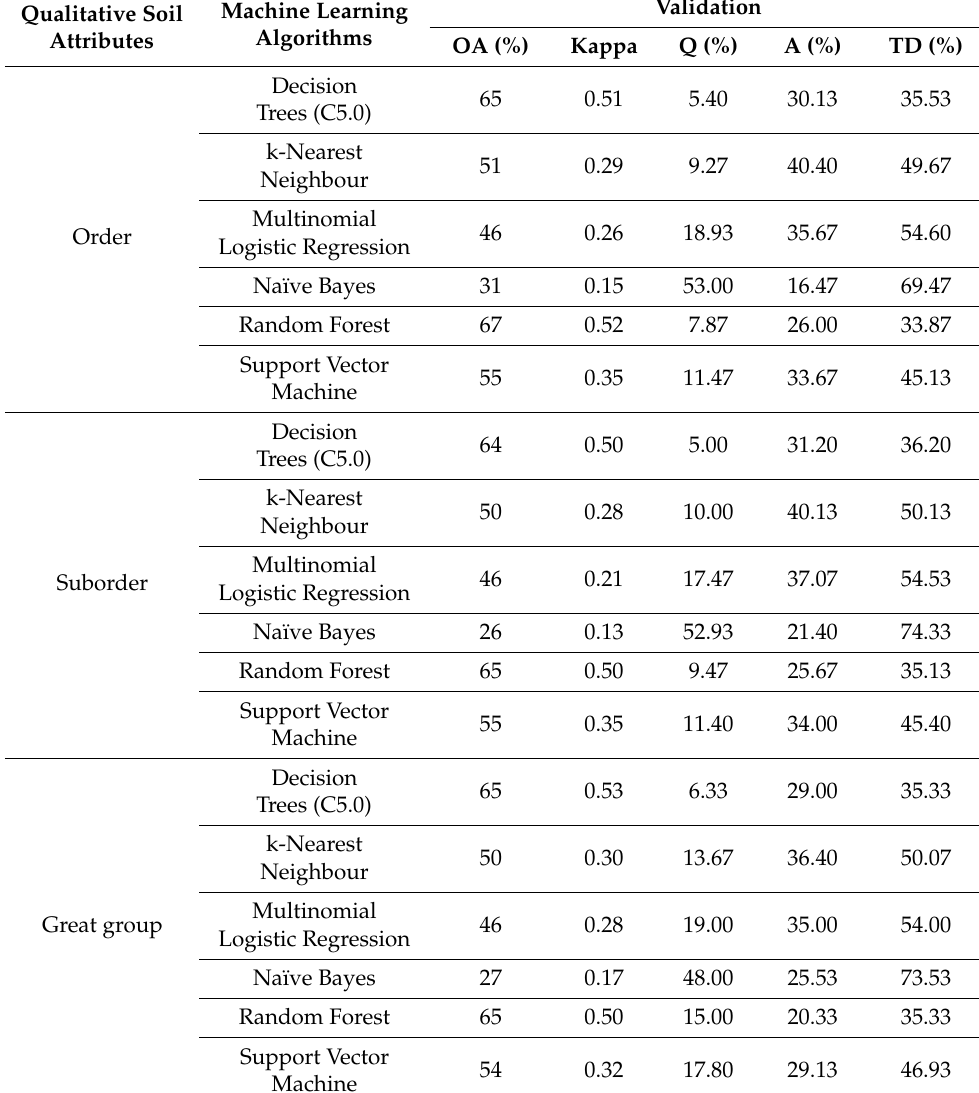
Table 5. Prediction evaluation metrics assessed for categorical soil